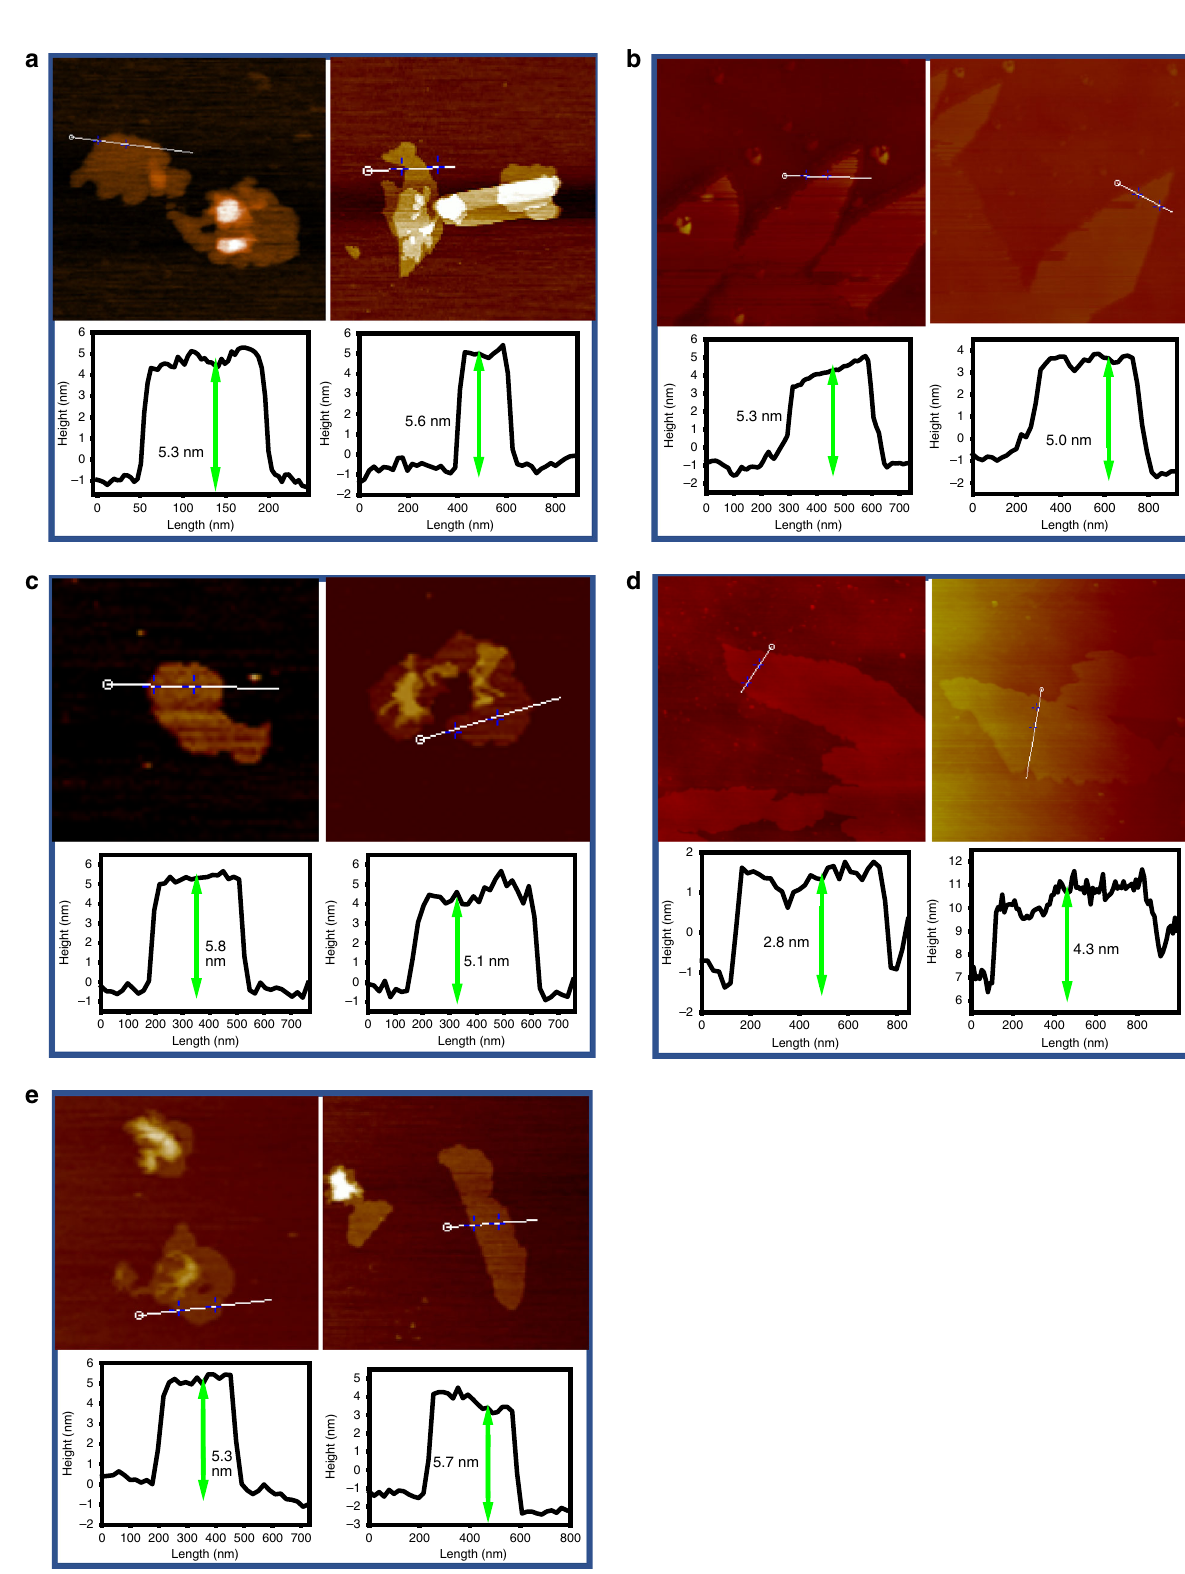
Fig. 3 Thickness characterization of gersiloxenes. AFM images and corresponding height pro fi les of gersiloxenes nanosheets. a x = 0.1. b x = 0.3. c x = 0.5. d x = 0.7. e x = 0.9. AFM atomic force microscope. Source data are provided as a Source Data fi